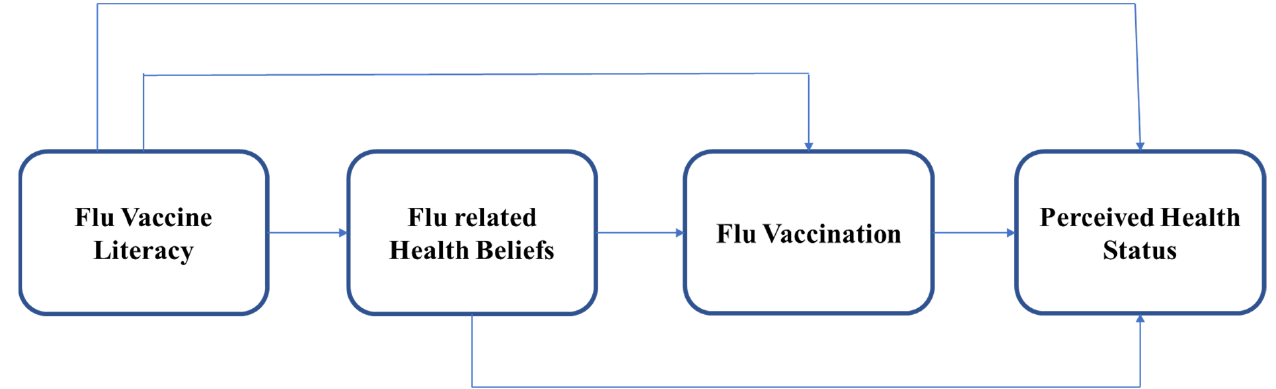
Figure 1. Study Design for the Current Study. Flu Vaccine literacy, Flu-related Health Beliefs, Flu Vaccination, and Perceived Health Status.